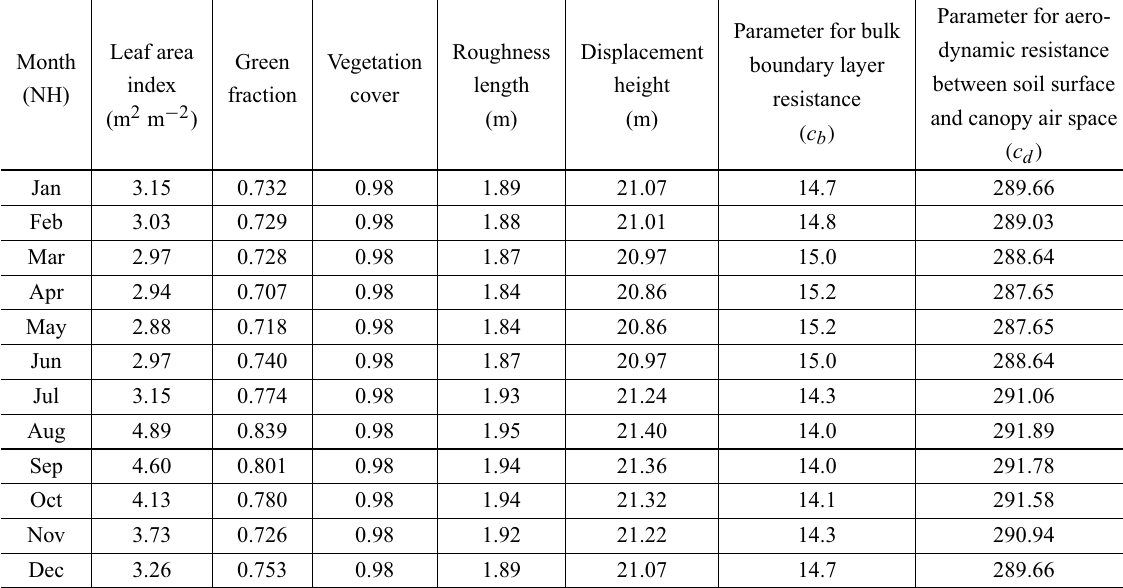
Time-varying biophysical parameters (LAI, green fraction, vegetation cover, roughness length and displacement height) are derived from NDVI data; the parameters c b and c d are estimated from z 0 . Values shown are valid for Northern Hemisphere (NH; for Southern Hemisphere, a 6 month-shift is necessary to account for interhemispheric seasonality